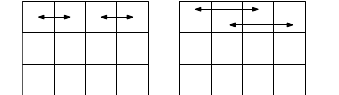
Figure 2: The linear layer, where the left/right part represents S_SW/B_SW.